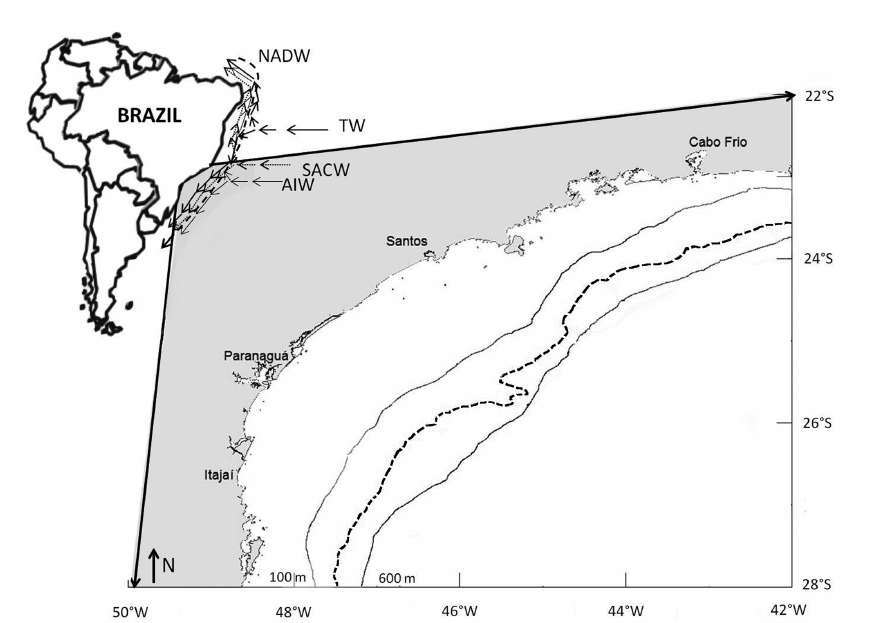
Fig. 1. – Map of the modelled area (between 100 and 600 m). This drawing is based on REVIZEE (MMA 2006). The dashed line represents the continental shelf break (200 m). Arrows represents the main currents: South Atlantic Central Water (SACW); Antarctic Intermediate Water (AIW); Tropical Water (TW); North Atlantic Deep Water